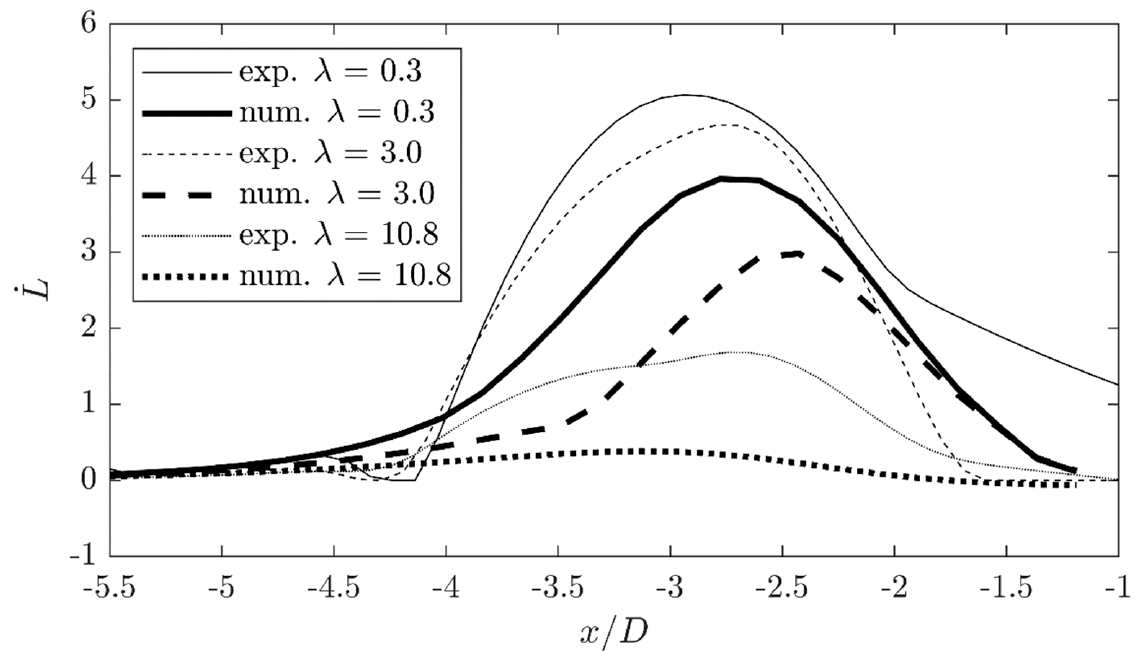
Figure 18. Comparison of the elongation rate for the different viscosity ratios at a Reynolds number of Re = 2000 based on the experimental measurements and the numerical simulations.